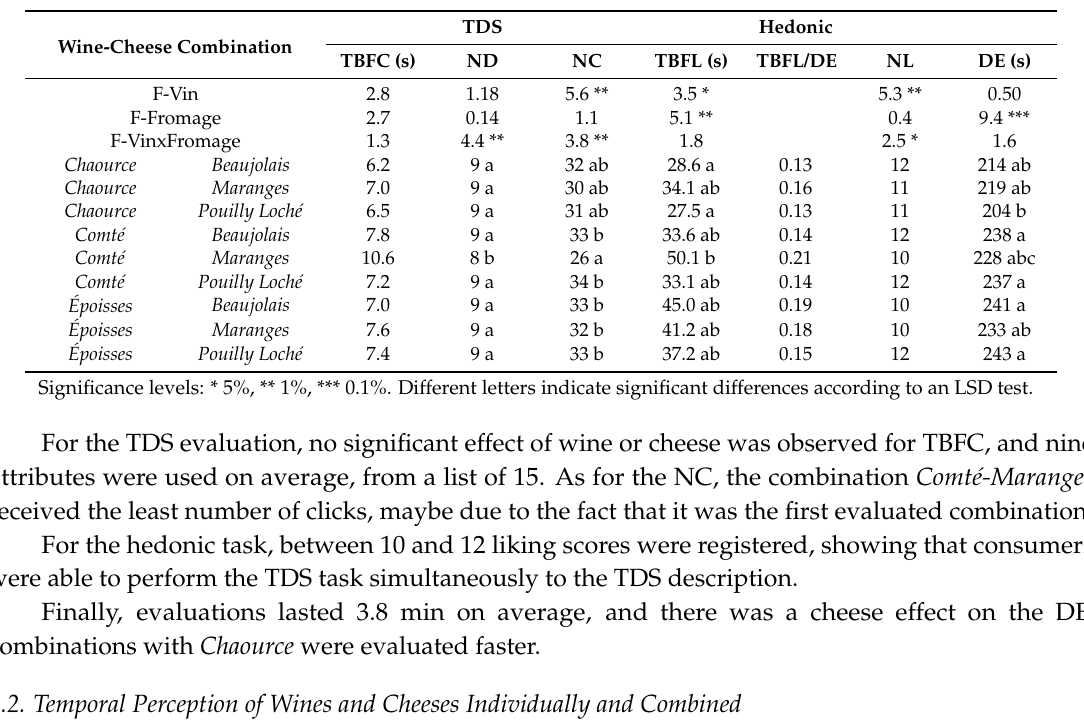
Table 5. Mean values for: TBFC, ND, NC, TBFL, NL and total DE for wine-cheese combinations evaluated in multiple-intake